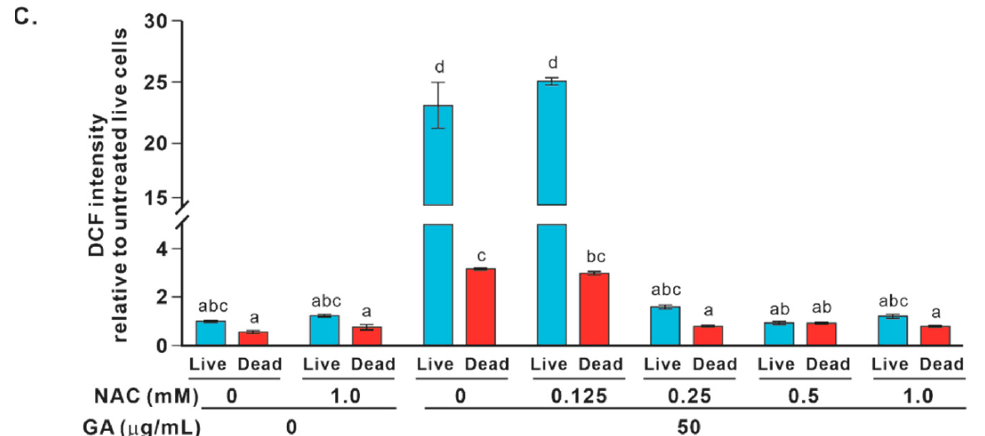
Figure 6. The effect of GA and NAC treatment on the level of intracellular ROS in CL1-0 cells expressing PERP-428C or PERP-428G . ( A ) The effects of NAC, GA and NAC/GA treatments on the death of cells expressing CL1-0/ PERP-428G were determined by PI staining, and the effects on ROS levels were determined by H 2 DCFDA. After 24 h of treatment, NAC only slightly increased ROS without significant cell death. ( B ) For cells expressing CL1-0/ PERP-428C , GA (50 µ g/mL) treatment significantly increased ROS levels. Cotreatment with GA and higher NAC concentrations (0.25, 0.5 and 1.0 mM) enhanced cell death (red in top panel) and strongly reduced ROS levels (red in bottom panel). ( C ) Quantitation of ROS levels in ( B ). The living cells after GA treatment and GA and 0.125 mM NAC cotreatment had high ROS levels, but when the NAC concentrations were higher than 0.25 mM, the living cells had low ROS levels. One-way ANOVA and the Scheff é test were used to analyze the ROS between cells expressing PERP-428C and PERP-428G treated with GA and NAC; F(13,28) = 715.645, p = 1 × 10 − 31 . The letters in the figure indicate the homogeneous subsets, and data sharing the same letter are not significantly different as determined by the Scheff é test ( p >